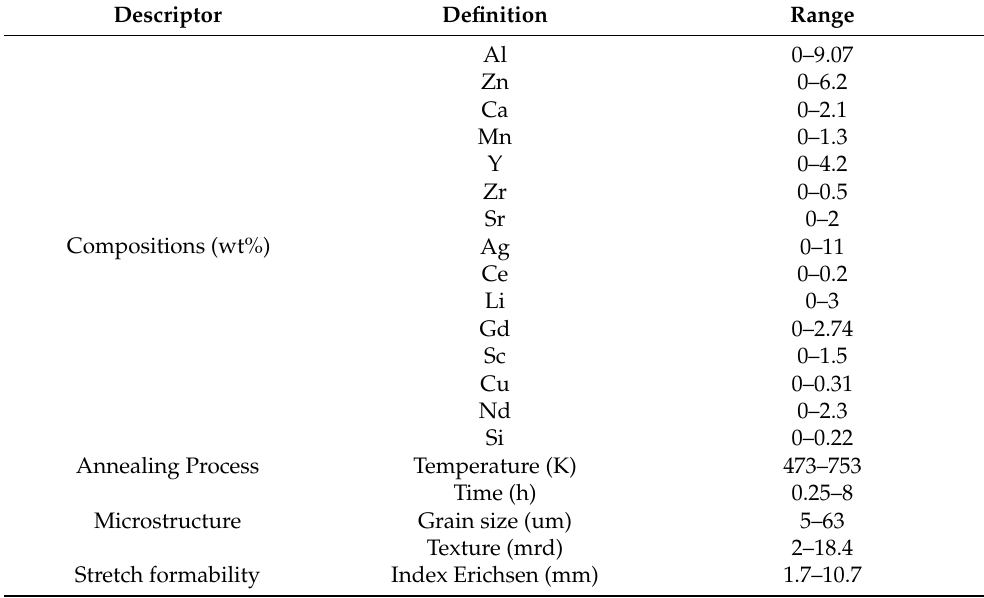
Table 1. Definitions and range of the formability descriptors in